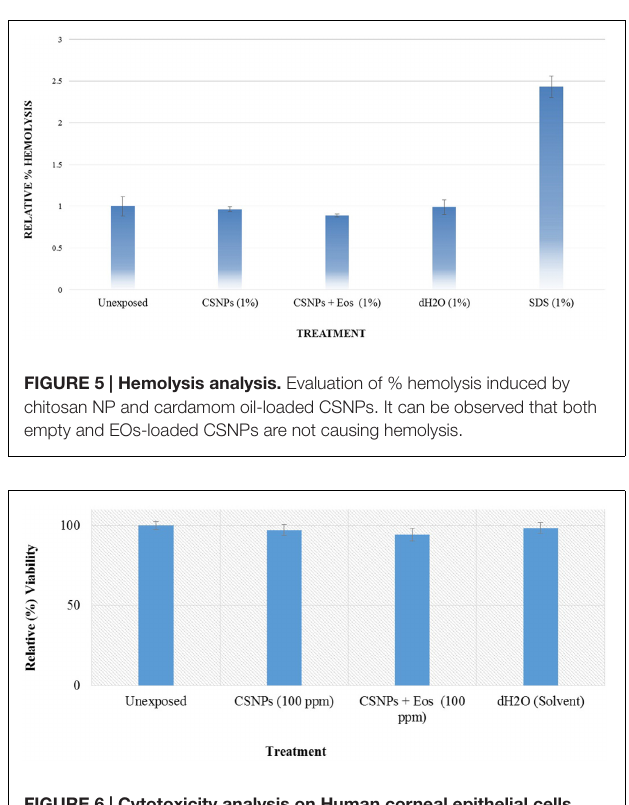
Frontiers in Microbiology |